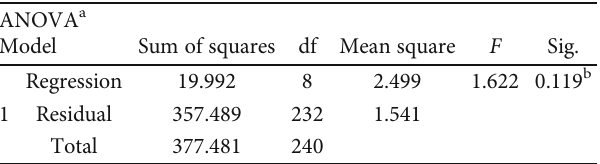
Table 8: Regression analysis of